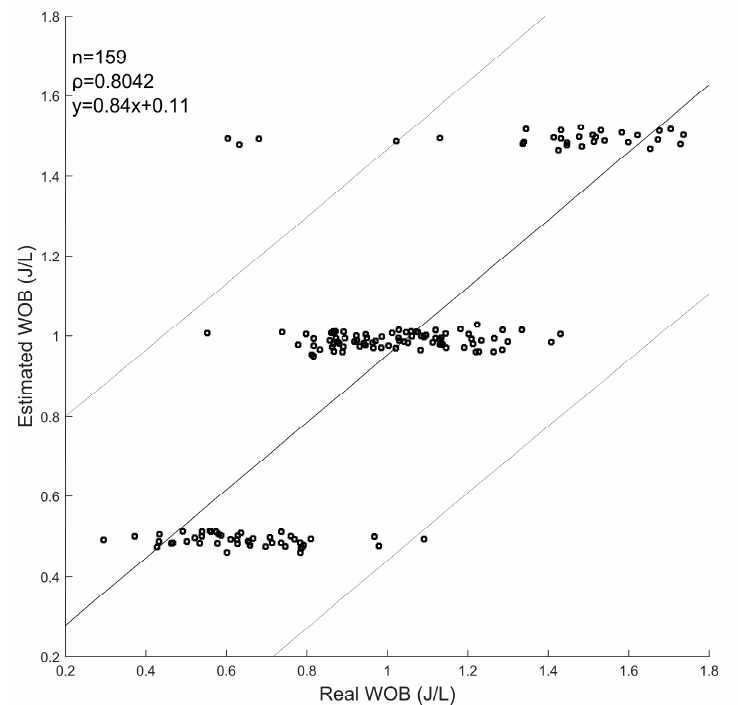
Figure 7. Real work of breathing (WOBr) compared with the estimated work of breathing (WOBe) in each one of the groups. The linear regression analysis is presented.